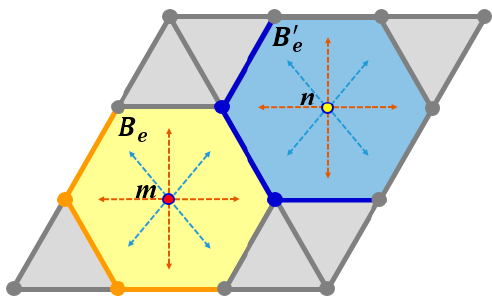
Figure 8. Any translation vector that starts at the even midpoint ( m ) and ends within the hexagonal region ( B e ) will produce a strongly-bijective translation. The orange- and blue-colored borders belong to B e and 𝐵 (cid:3032)(cid:4593) regions respectively, while the gray-colored borders belong to other regions.